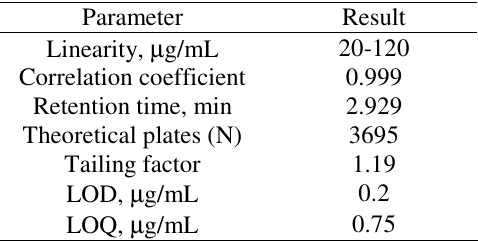
Table 3. System suitability parameters